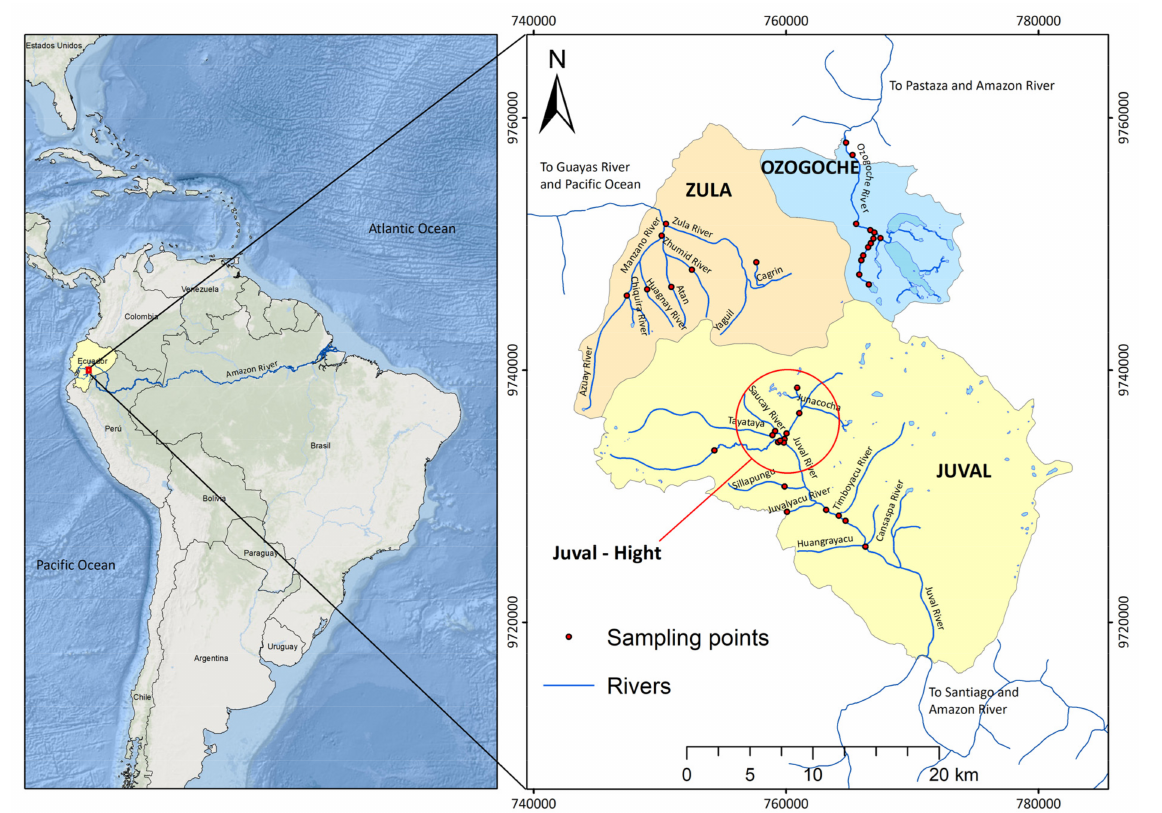
Figure 1. Study area and location of sampling points. The red circle shows a subregion of the Juval micro-watershed, labeled Juval–Hight.